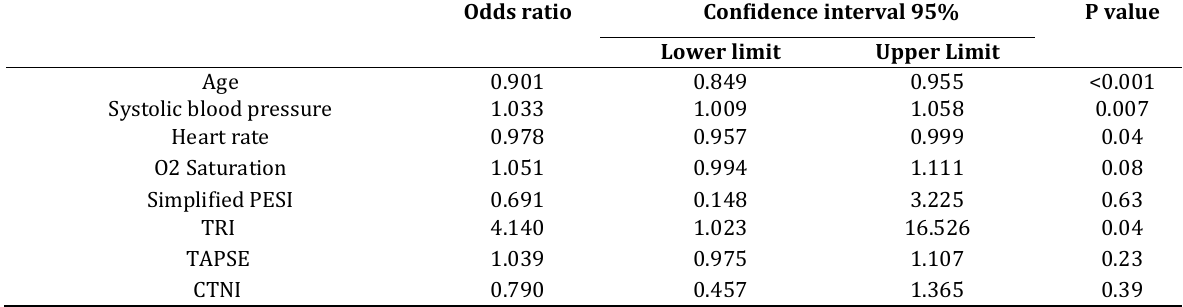
Table 3: Multiple logistic regression analysis evaluating the predictive factors on mortality Odds ratio Con4idence interval